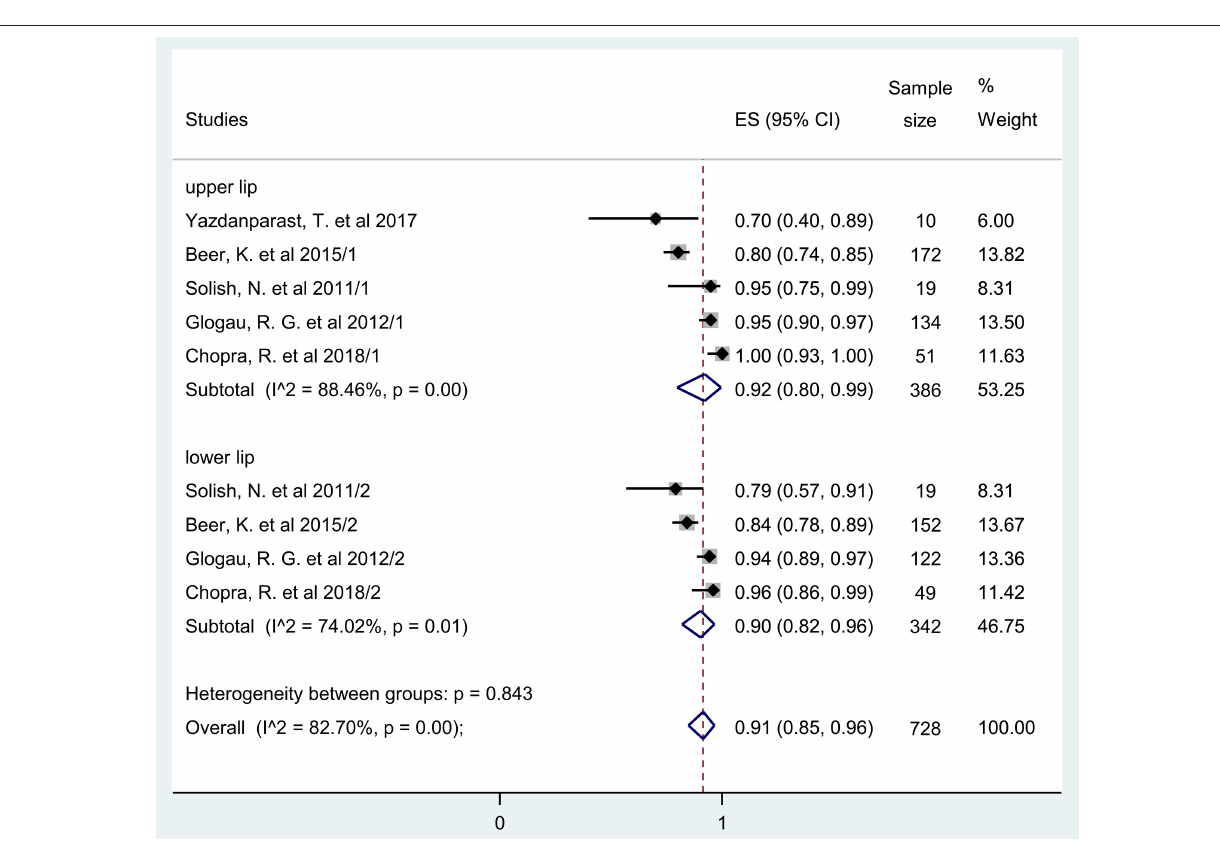
FIGURE 3 | Estimate of rate of responders at 2 months after treatment for the upper and lower lips. Overall, 92% (95% CI: 80–99%) and 90% (95% CI: 0.82–96%) of included participants had at least one grade improvement on a validated lip fullness scale regarding their upper and lower lips, respectively, after 2 months of initial